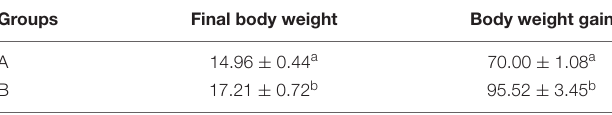
TABLE 2 | The growth performance of A. japonicus in stage